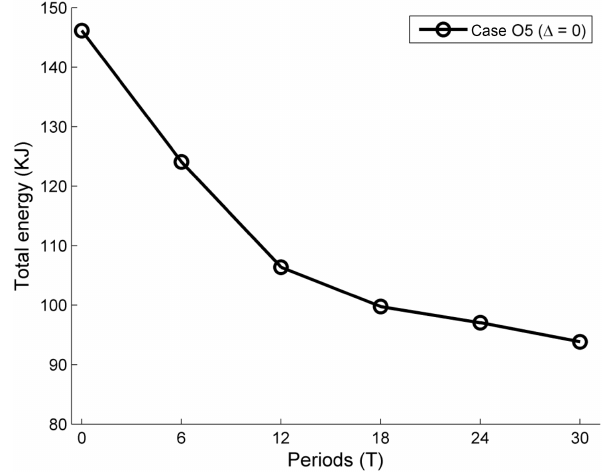
Figure 13. Vertical integrals of the radiating energy flux in the (a) front and (b) rear transects of the mode-2 ISW in the control exper- iment (case O5 with (cid:49) = 0) at different times, where “ot” denotes the oscillating tail and “am” denotes the amplitude-modulated wave packet.